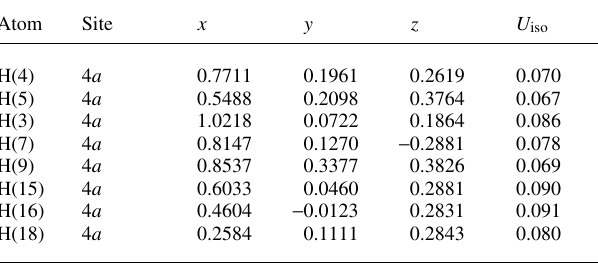
Table 2. Atomic coordinates and displacement parameters (in Å 2 )